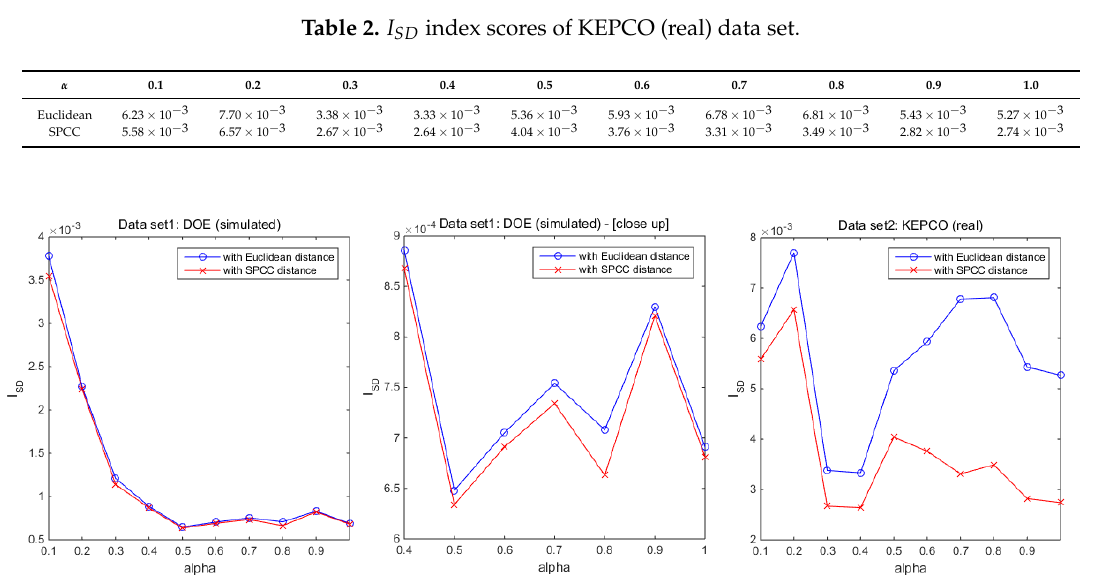
Figure 4. I SD clustering quality index score